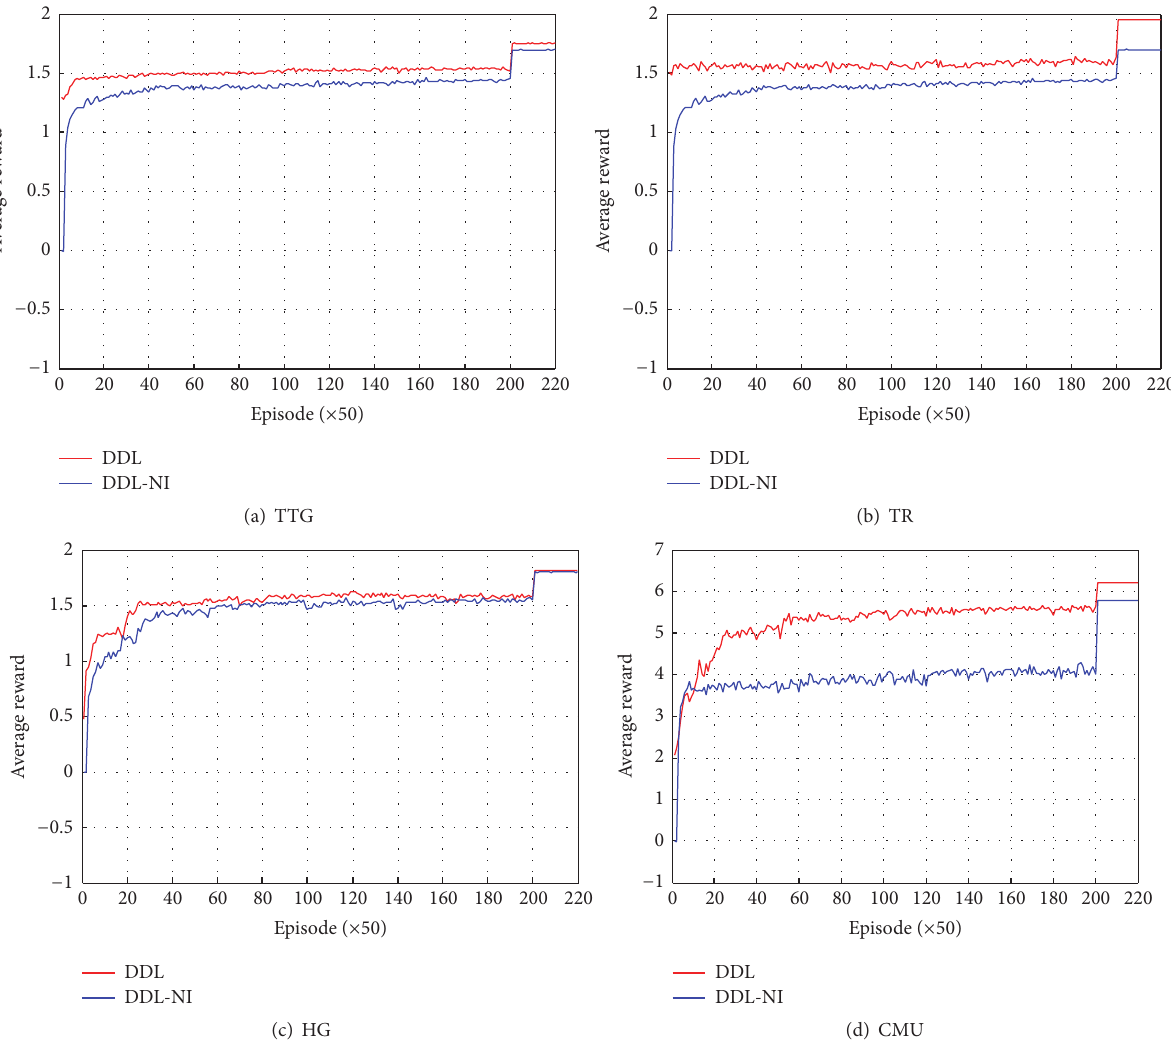
Figure 4: The learning curves of the tested approaches in games TTG, TR, HG, and CMU when 𝜌 = 1.0 and 𝜎 = 0